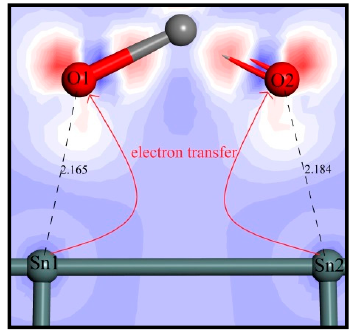
Figure 9. Electron density difference of oleate–cassiterite adsorption configuration. Blue area represents losing electrons, and red contours indicate an electron density increase (colour codes: Gray—C, Red—O, Dark Gray—Sn).